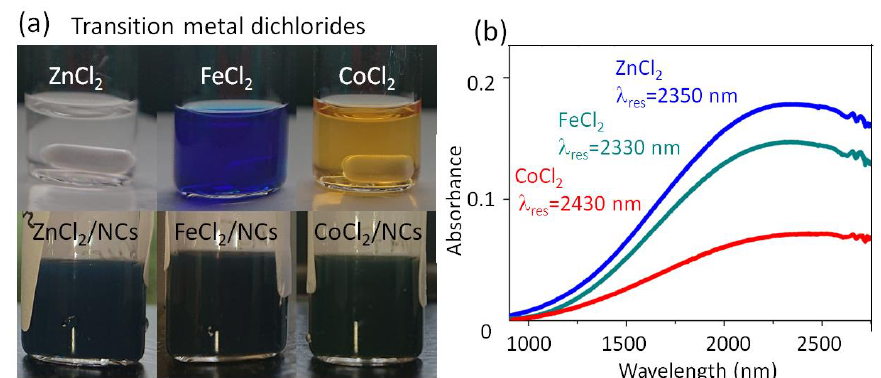
Figure 3. ATO NCs with a Sb doping concentration of 20% after ligand exchange to transition metal dichloride ligands. ( a ) Photo of ZnCl 2 , FeCl 2 , and CoCl 2 dissolved in NMF (upper row) and of the NCs after completed ligand exchange (lower row). ( b ) Infrared absorbance spectra of NCs ’ films with various ligand species, also providing the LSPR wavelengths.